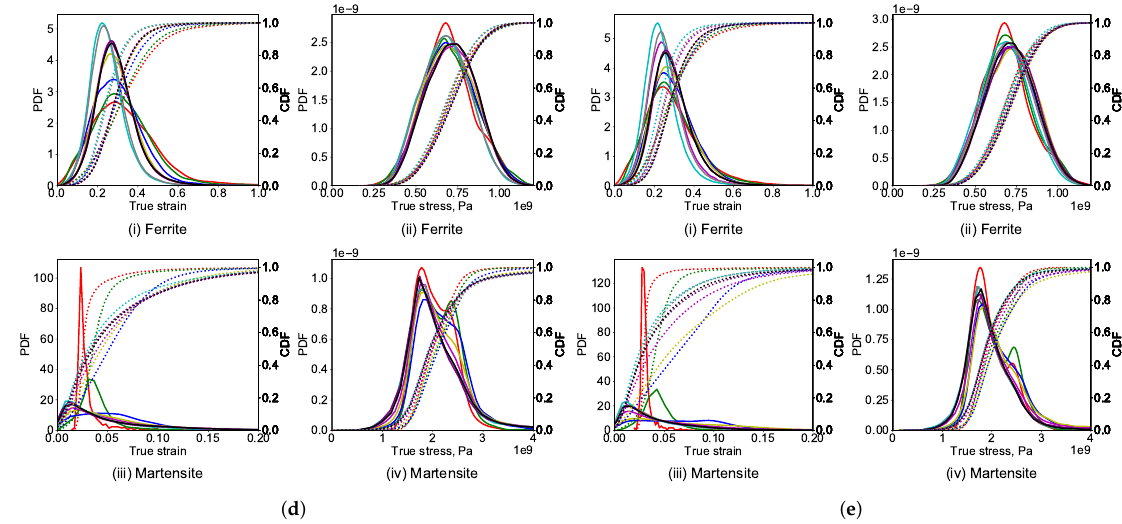
Figure 7. Comparison of ( i ) local strain distribution in ferrite, ( ii ) local stress distribution in ferrite, ( iii ) local strain distribution in martensite, ( iv ) local stress distribution in martensite, using Probability Distribution Functions (PDF) and Cumulative Distribution Functions (CDF) curves for RVEs with varying D f , ( a ) RVE-A, ( b ), RVE-B ( c ), RVE-C ( d ), RVE-D ( e ), and RVE-E at 25% of global true strain.